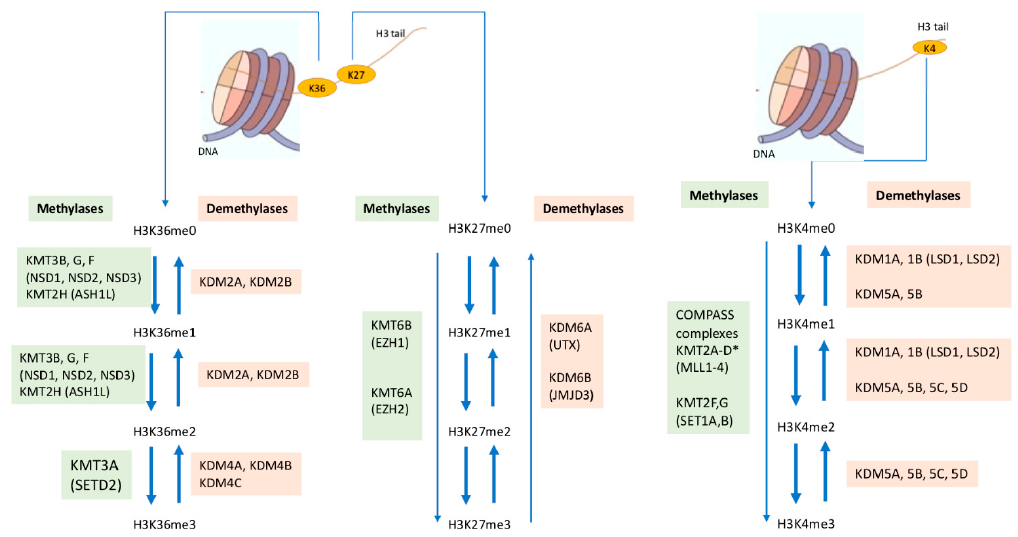
Figure 1. Action of the methylases and demethylases involved in the creation and removal of K36, K27, and K4 methyl marks on histone 3. Names in brackets are alternative names for the indicated enzymes. * KMT2A (MLL1) trimethylates a set of genes including HOX genes; KMT2B (MLL2) adds methyl groups to bivalent promoters in ESC; KMT2C (MLL3) and D (MLL4) can also add the monomethyl mark to H3K4 on active distal enhancers.